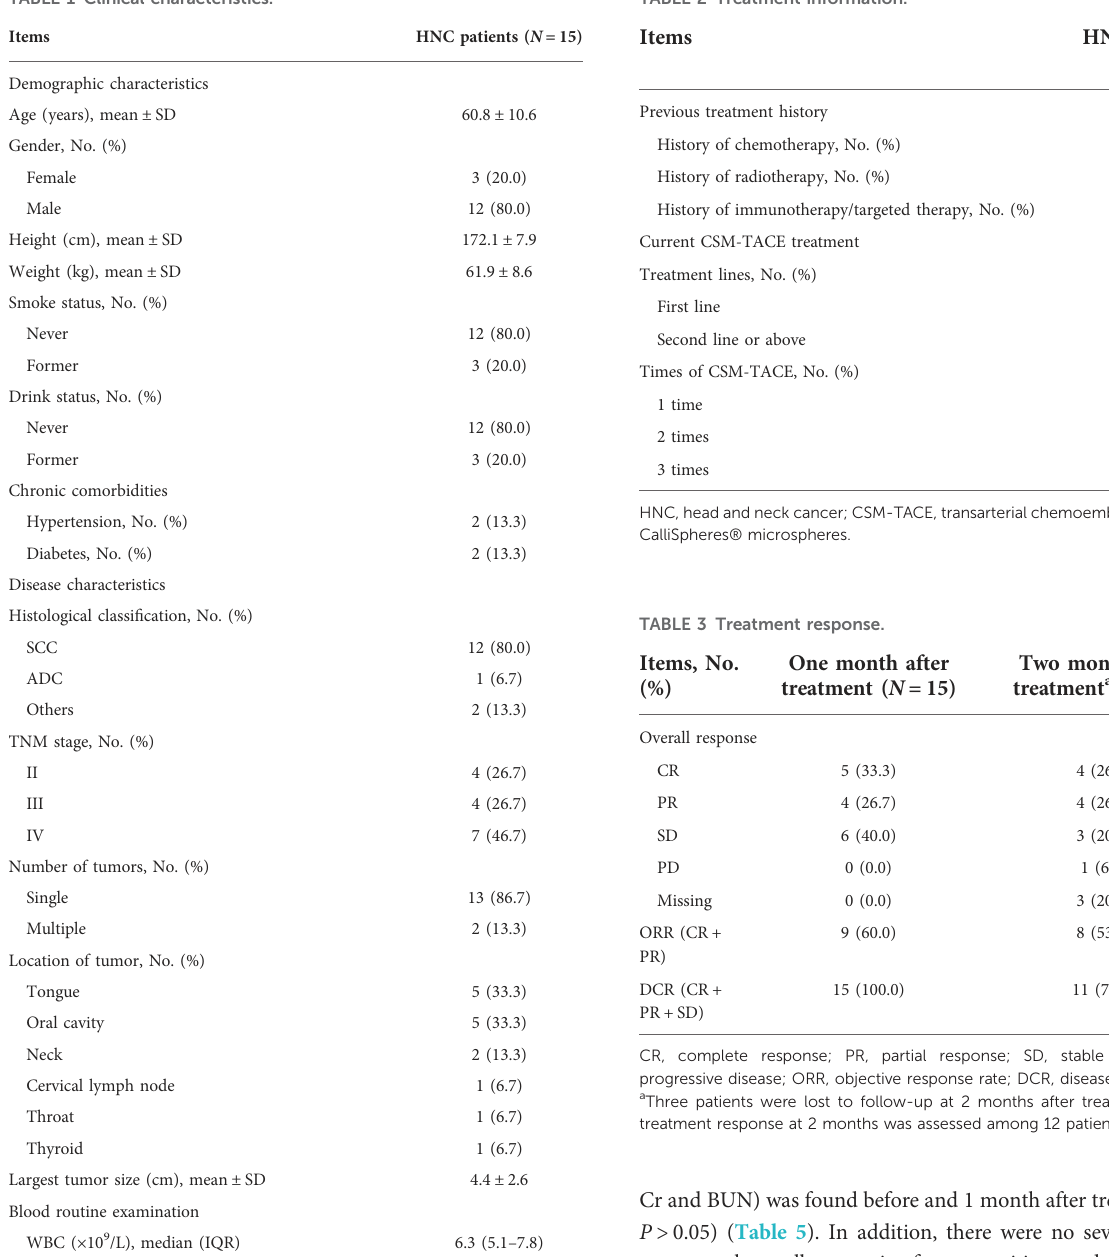
TABLE 1 Clinical characteristics. TABLE 2 Treatment information.